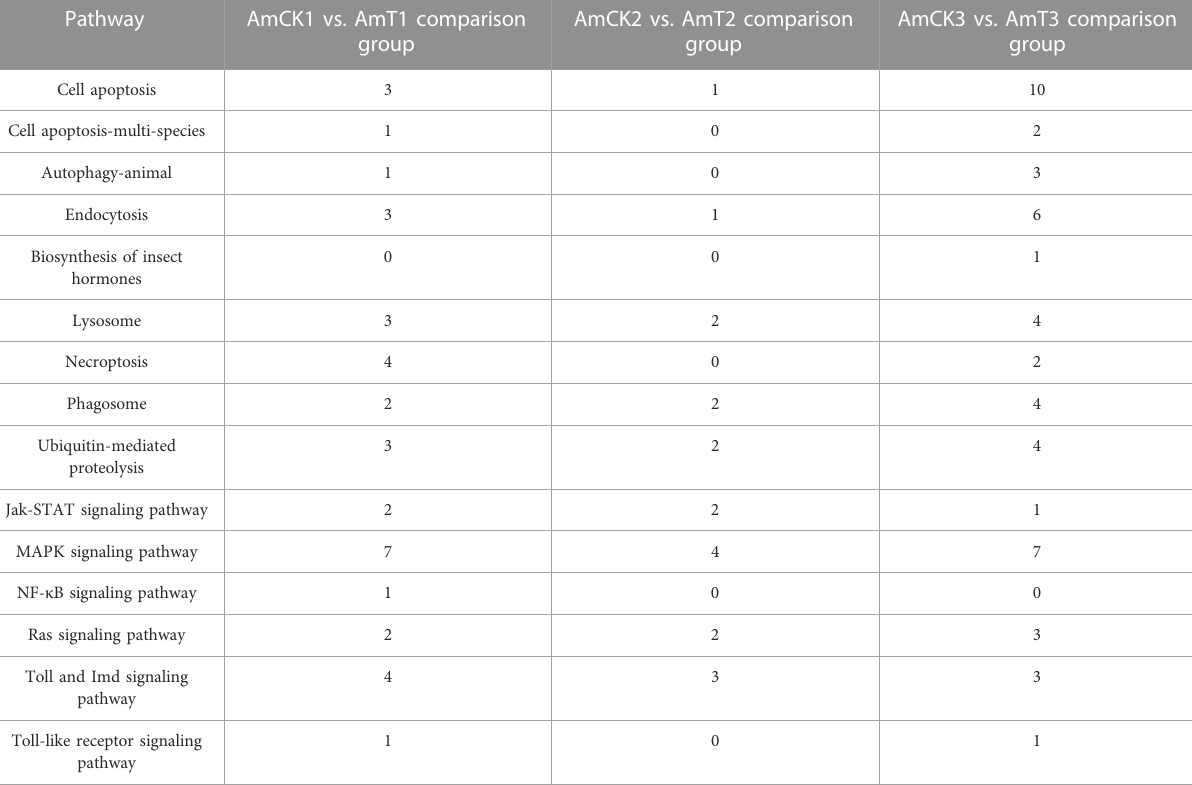
TABLE 1 Summary of neighboring genes of DElncRNAs associated with immune